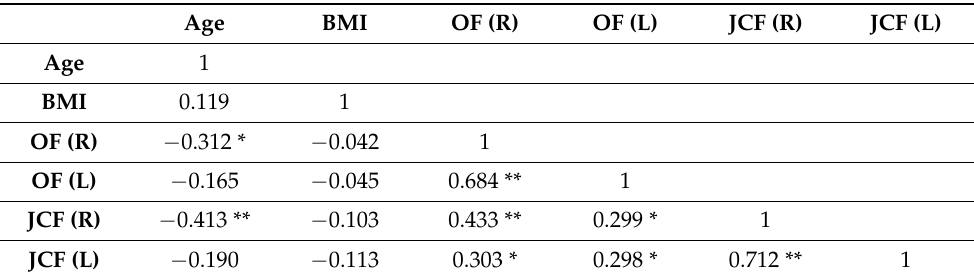
Table 3. Correlation coefficients for each item (n = 62).